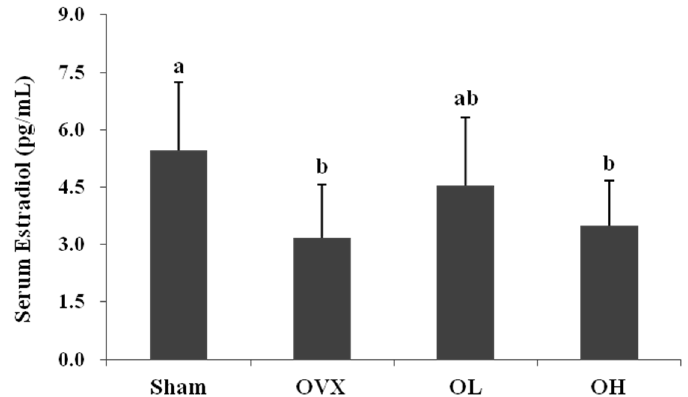
Figure 2. Serum estradiol level of each group. Values are mean ± SD ( n = 7 for each group); the different letters (a > b > c) within a column indicate significant differences ( p < 0.05) determined by Duncan’s multiple range test; Sham, the non ‐ OVX control; OVX, the OVX ‐ control; OL, the OVX + 100 mg/kg b.w. of hawthorn extract; OH, the OVX + 200 mg/kg b.w. of hawthorn